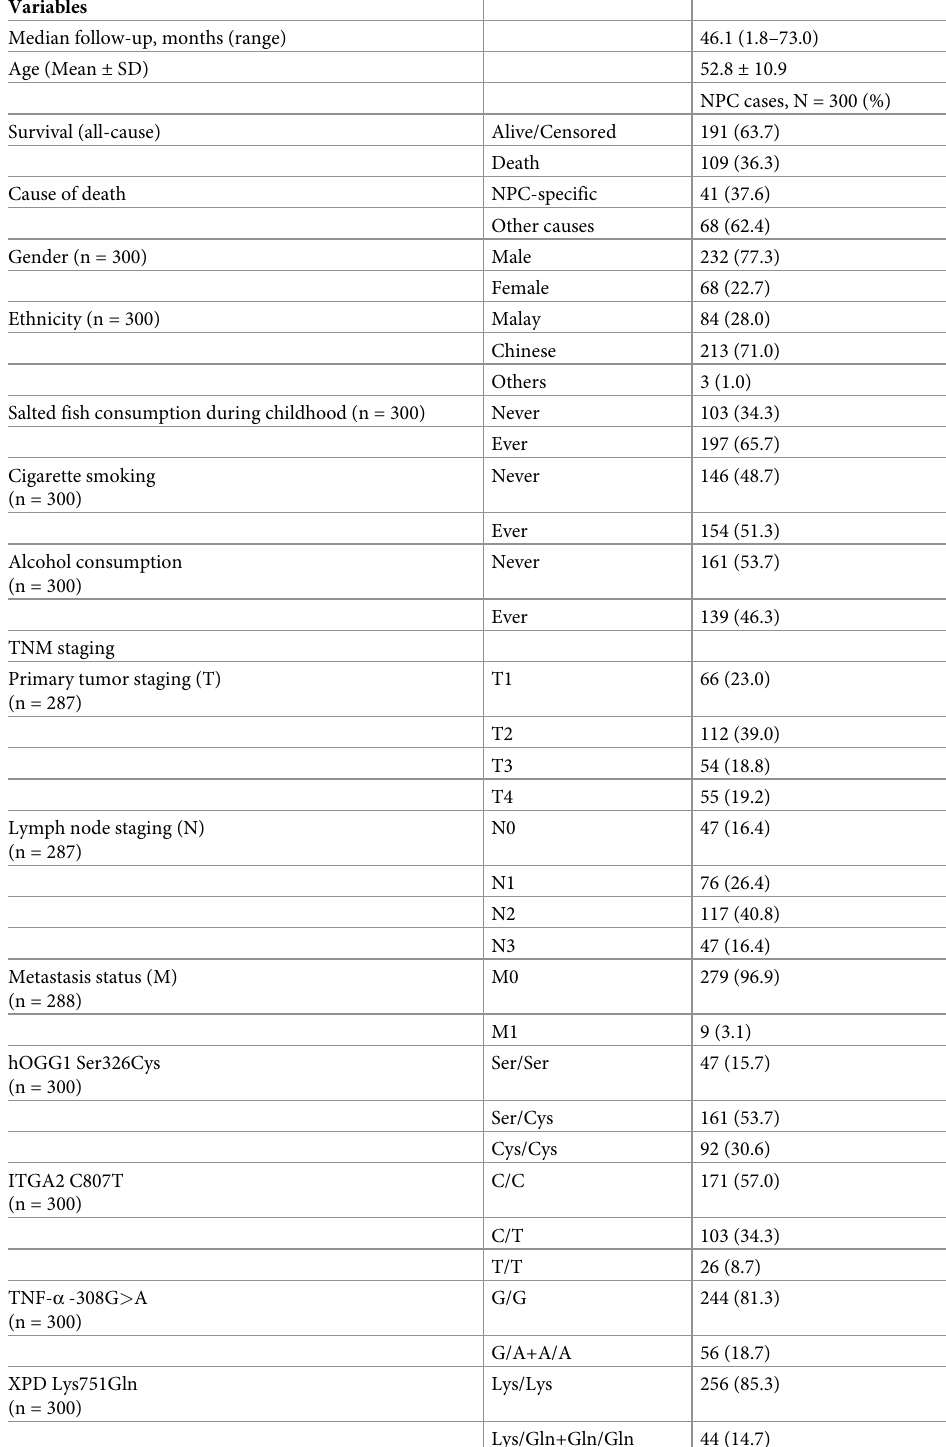
Table 2. Characteristics of NPC patients (N =